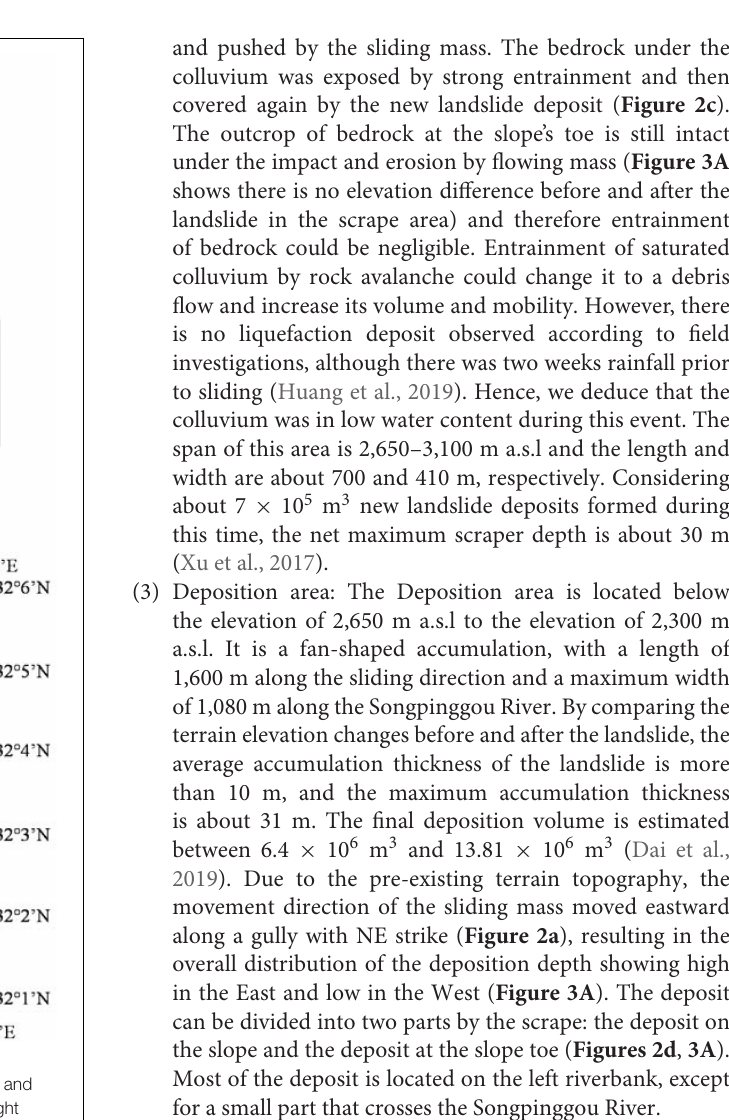
source mass is between 3.0 × 10 6 m 3 and 6.3 × 10 6 m